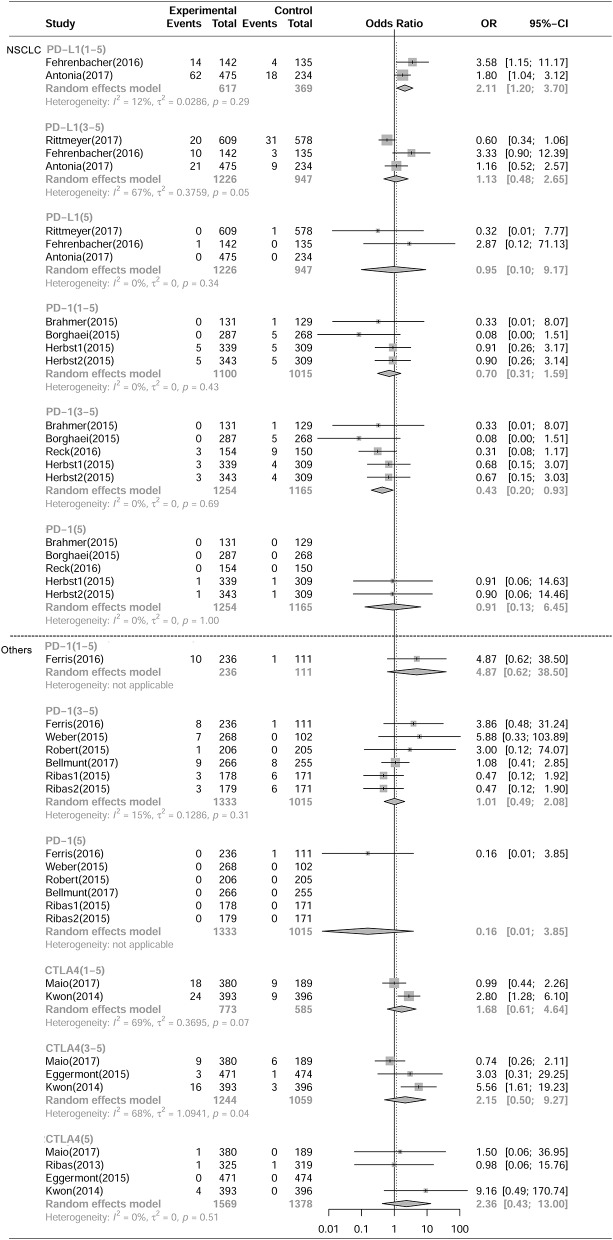
Forest plot analysis of pneumonia of different ICIs in different tumoral types. NSCLC, non-small cell lung cancer; Others, including MM, HNSCC, Prostate cancer, Mesothelioma PD-L1, PD-L1 inhibitor V.S. chemotherapy/placebo; PD-1, PD-1 inhibitor V.S. chemotherapy; CTLA4, CTLA4 inhibitor V.S. chemotherapy/placebo; G1-5, grade 1-5; G3-5, grade 3-5, G5, death.